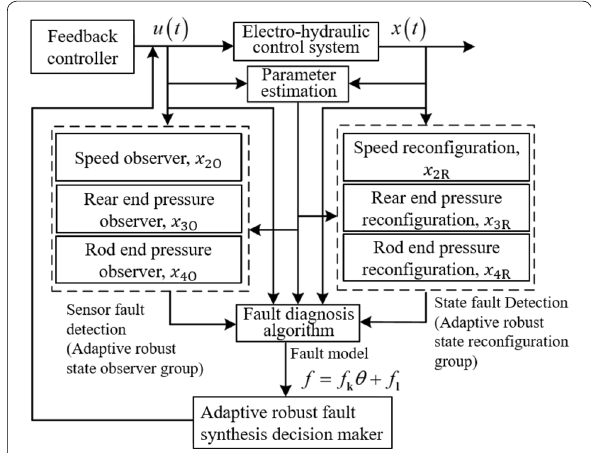
Figure 23 Fault diagnosis method based on the robust observer and the state reconstruction